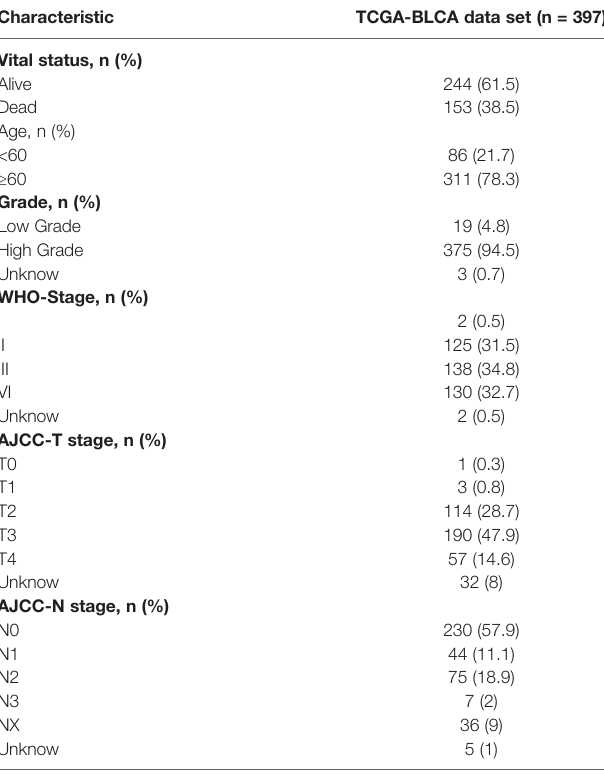
TABLE 2 | Summary of clinical characteristics of TCGA-BLCA patient data sets in the study.